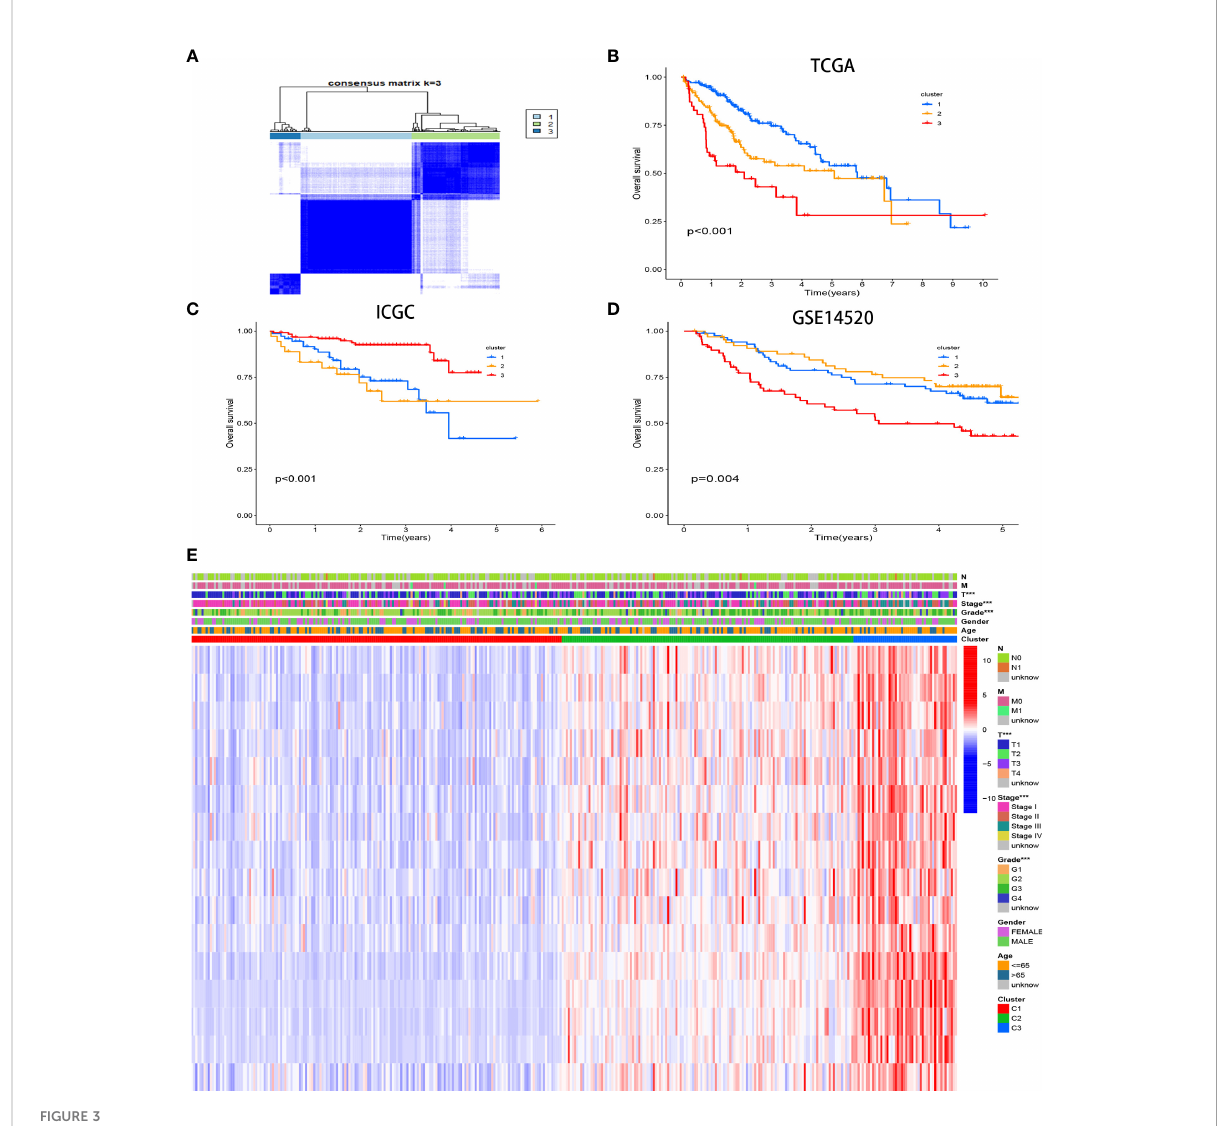
FIGURE 3 Consensus matrices of samples in the TCGA-HCC cohort via the unsupervised consensus clustering method (K-means) (A) . Survival analysis of the different CR clusters in the TCGA (B) and ICGC (C) cohorts and GSE14520 (D) . Heatmap of the clinicopathological manifestations among the CR clusters (E)